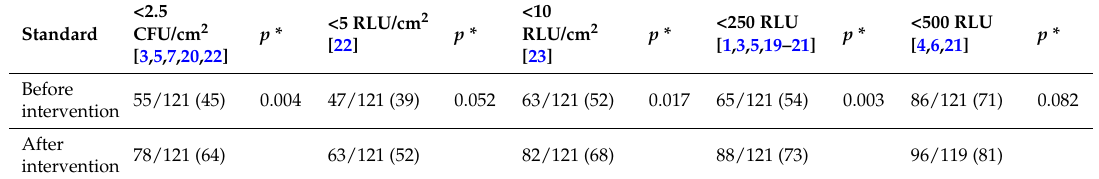
Table 4. Pass rate of all sampling sites determined by five different criteria before and after the intervention.